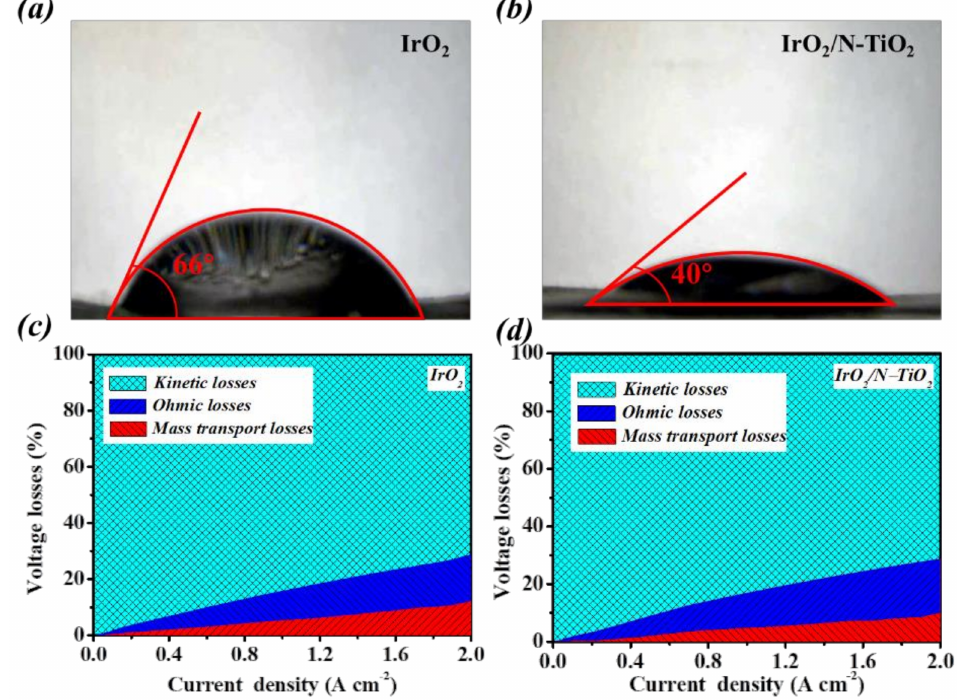
Figure 6. ( a , b ) Contact angles and ( c , d ) voltage losses of IrO 2 and IrO 2 /N–TiO 2